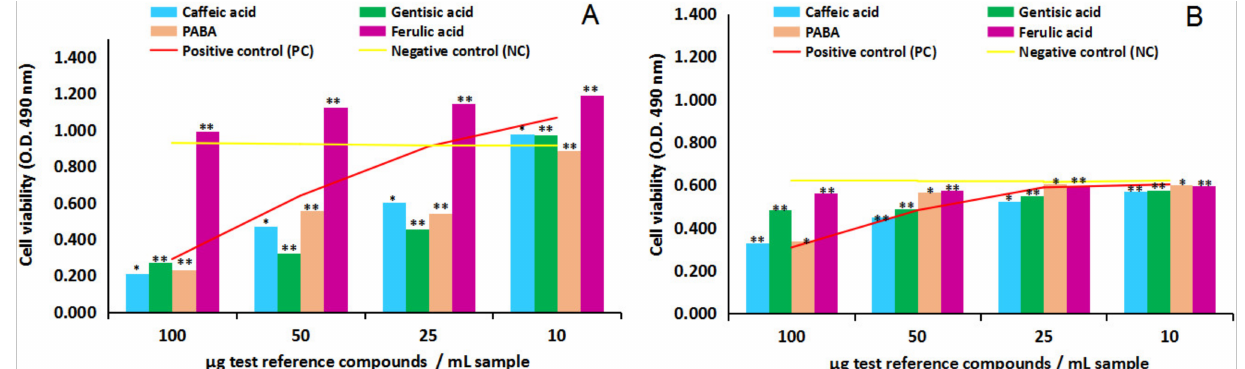
Figure 4. Effect of test reference compounds (caffeic acid, gentisic acid, ferulic acid and para- aminobenzoic acid/PABA) on human normal brain cell line NHA and human tumor brain cell line U87, in cytotoxicity MTS assay. ( A ) NHA cell line viability after 24 h of exposure to test reference compounds. ( B ) U87 cell line viability after 24 h of exposure to test reference compounds. Data were the mean of three replicates (n = 3). Note: * = results without statistical significance ( p > 0.05); ** = results with statistical significance ( p < 0.05).